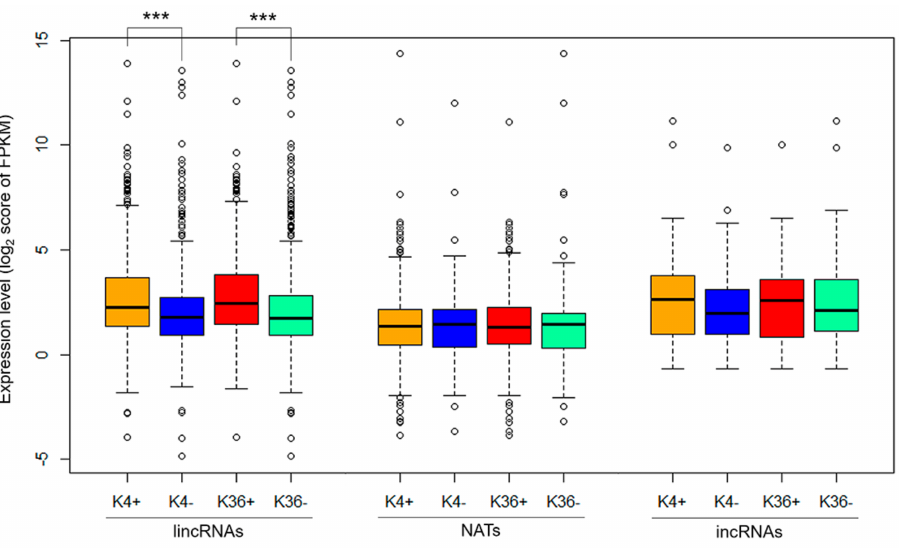
Figure 2. Boxplots of the expression level of each type of lncRNAs with (+) or without ( − ) H3K4me3 (K4) and H3K36me3 (K36) on the coding region of RJKB-T24. ***, p < 0.001 (Student’s t